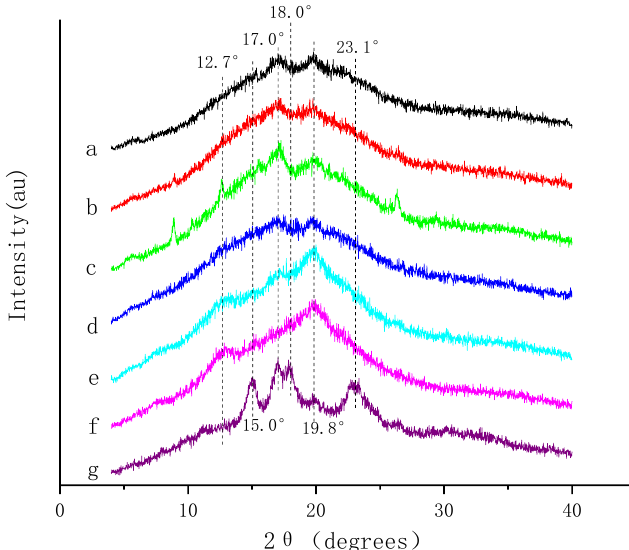
Figure 4. X-ray diffraction pattern of different standard substances and addition amounts polyphenol-amylose complexes. (a) 1% ferulic acid-amylose complex; (b) 3% ferulic acid-amylose complex; (c) 5% ferulic acid-amylose complex; (d) 1% catechin-amylose complex; (e) 3% catechin-amylose complex; (f) 5% catechin-amylose complex; (g) Amylose.